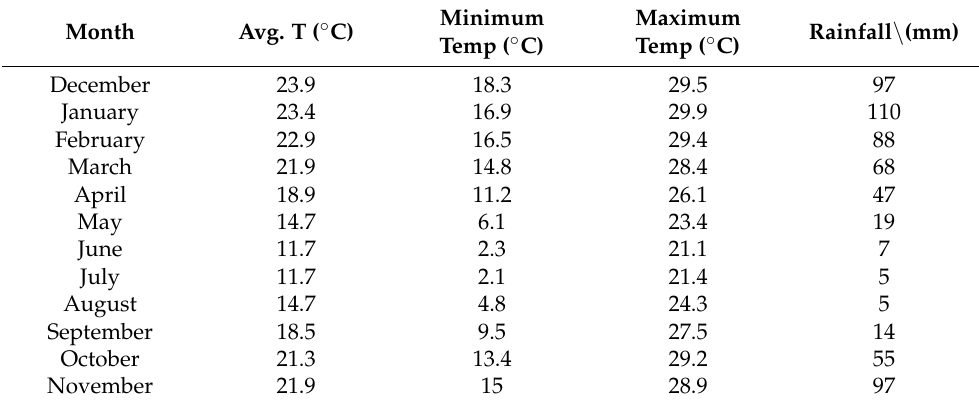
Table 3. Weather data for Hartbeesfontein/North West during the year 2019/2020.